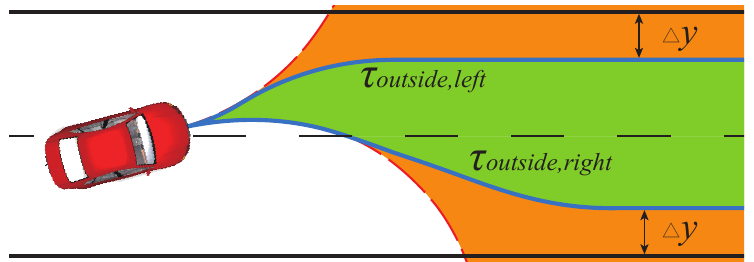
Figure 12. The reachable-set area and the driving envelope considering road